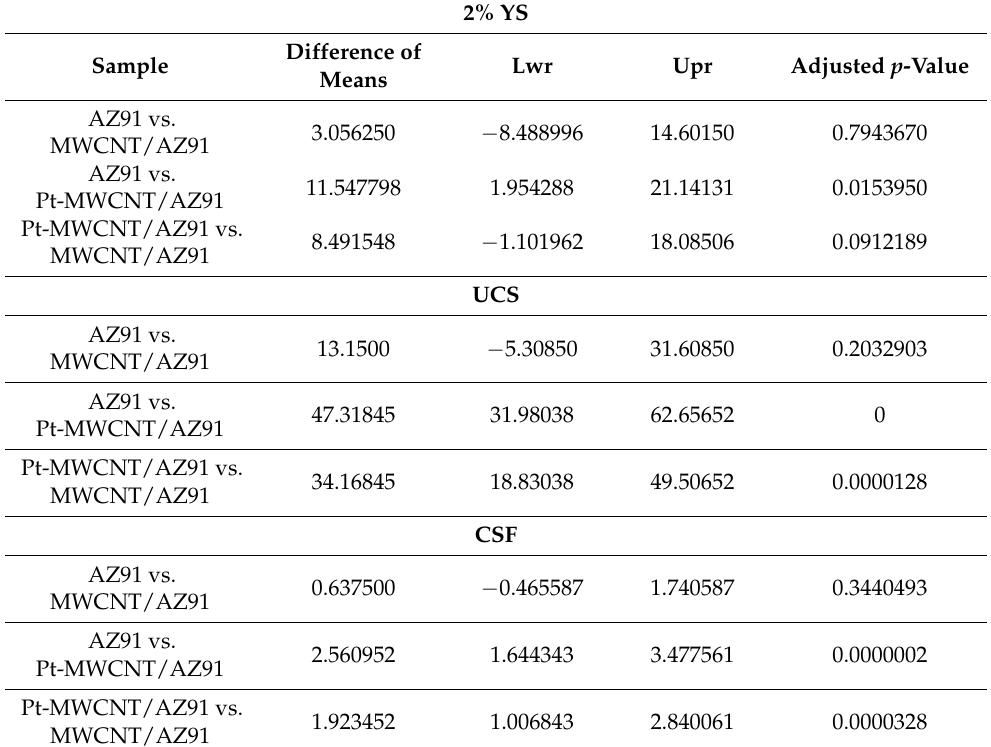
Table 3. Tukey HSD post-hoc test for yield strength (YS), ultimate compressive strength (UCS), and compression strain at failure (CSF) pairwise comparing the sample groups: pure AZ91, 0.05